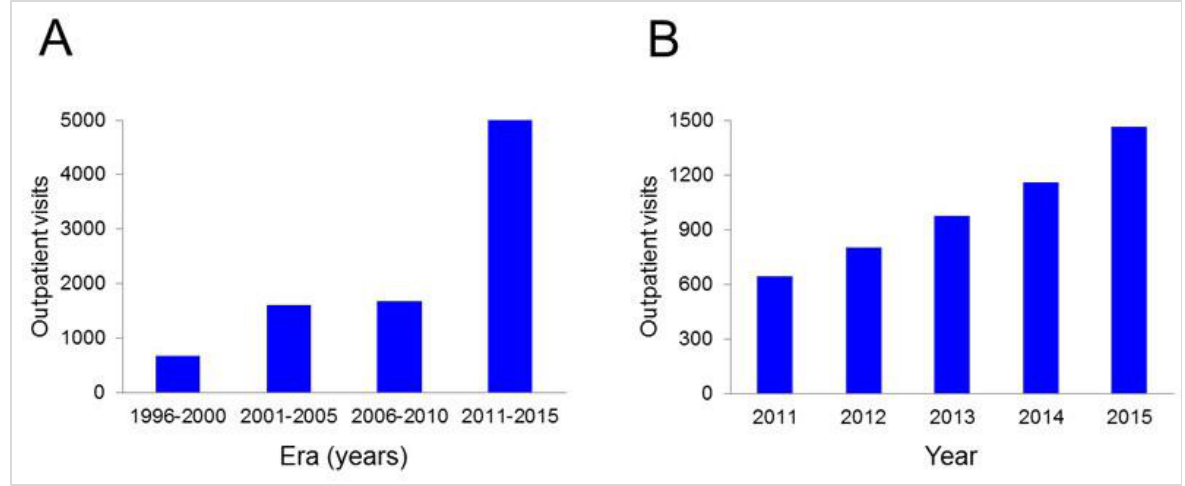
Figure 3: Number of outpatient visits during the study period. Panel A: Number of outpatient visits per 5-year intervals. Panel B: Number of outpatient visits per year over the last 5 years of the study